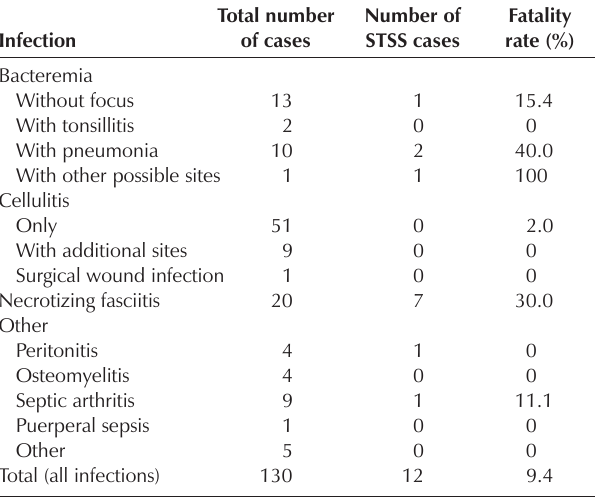
Primary clinical syndrome and outcome of invasive group A streptococcus in cases with complete clinical information available